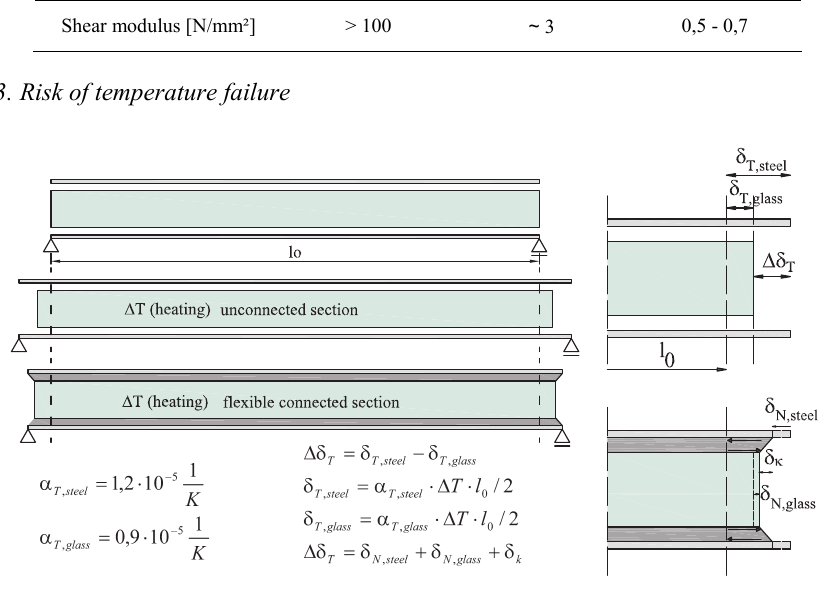
Figure 5: displacement of hybrid steel glass beam at